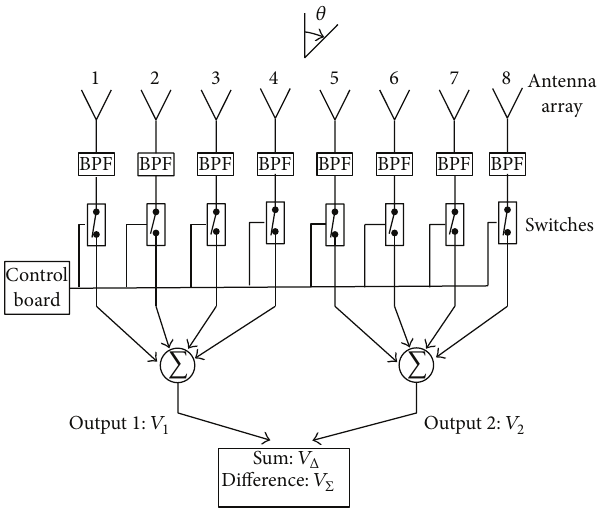
Figure 4: A phase-comparison monopulse system based on an 8- element 4D antenna